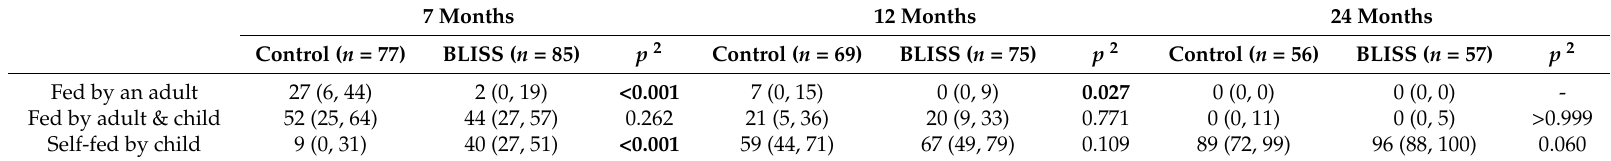
Table 2. Adherence to a baby-led approach to complementary feeding (using 3DDR data). 1.